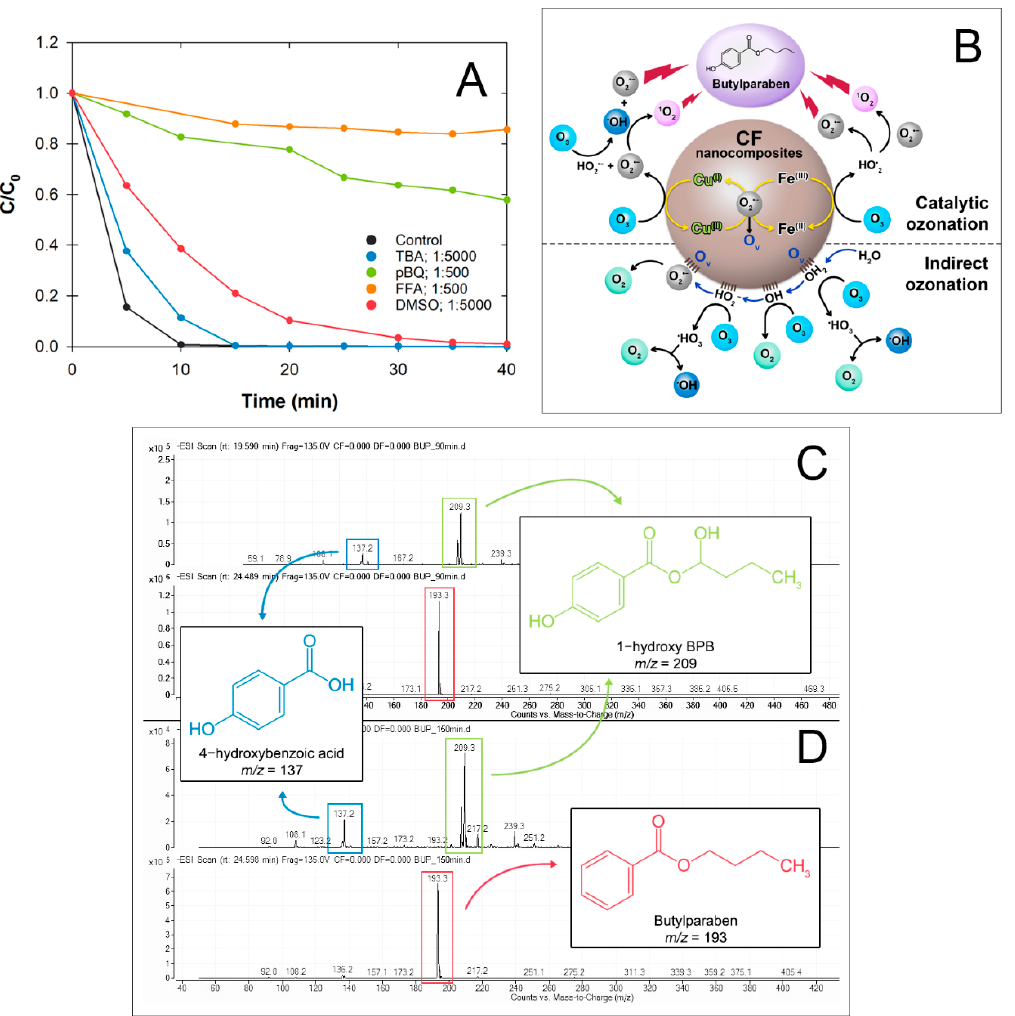
Figure 8. Following catalytic ozonation using O 3 /CF system: ( A ) effects of four scavenging agents on BP removal (catalyst: 0.2 g L − 1 , [BP o ]: 10 µ M, pH 7, 25 ◦ C), and ( B ) proposed catalytic mechanism of O 3 /CF for BP degradation; ( C , D ) mass spectra of BP major transformation products from LC–MS at ( C ) 90 min and ( D ) 150 min.